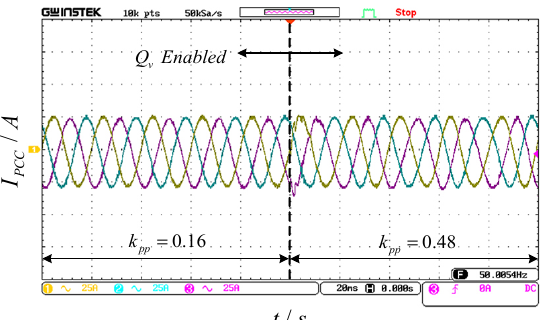
Figure 29. Experimental result of current waveform at PCC after reshaping when the proportional